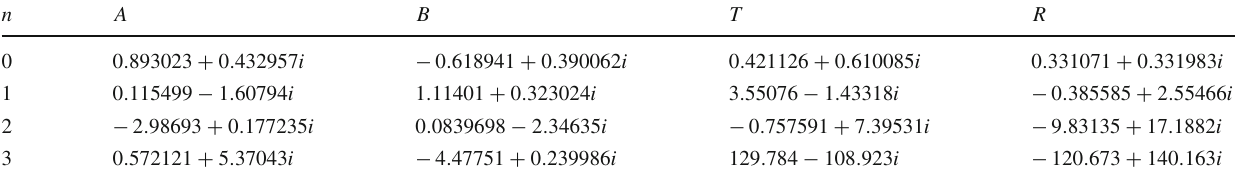
Table 6 Scattering coefficients for σ ↔ − σ scenario where m (cid:2) =